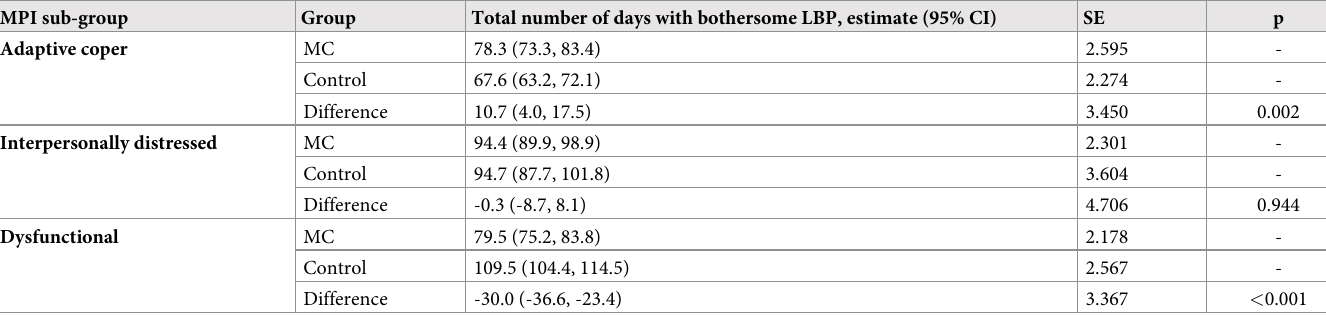
Table 2. Total number of days with bothersome low back pain, group estimates and differences between groups